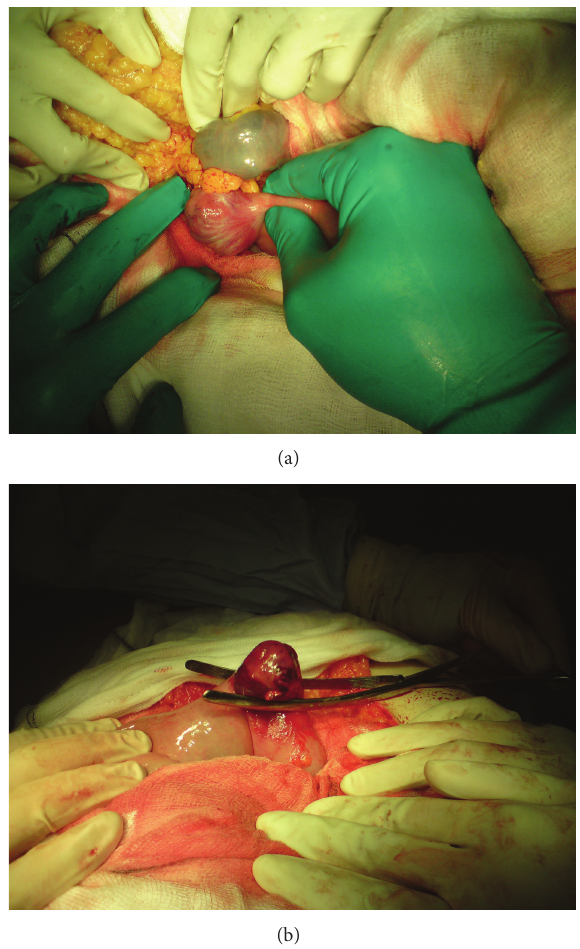
Figure1:(a)showsintraoperativephotographofhaemorrhagicexo- phytic anterior wall duodenal GIST. (b) demonstrates a clamp across the base of the tumour for intraoperative evaluation of bleeding cessation with the use of endoscopy. Local limited wedge resection was subsequently performed with clear margins. Surrounding bowel can be seen to be healthy allowing for a primary